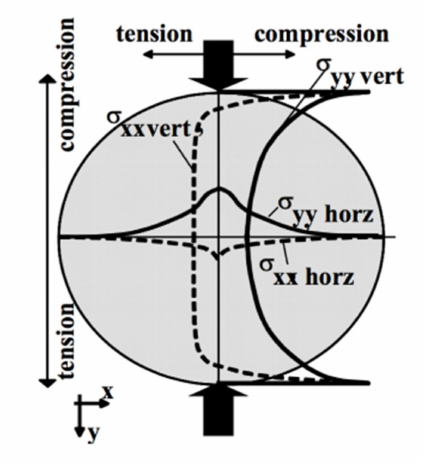
Figure 2. Stress distribution along the vertical and horizontal directions using indirect tensile